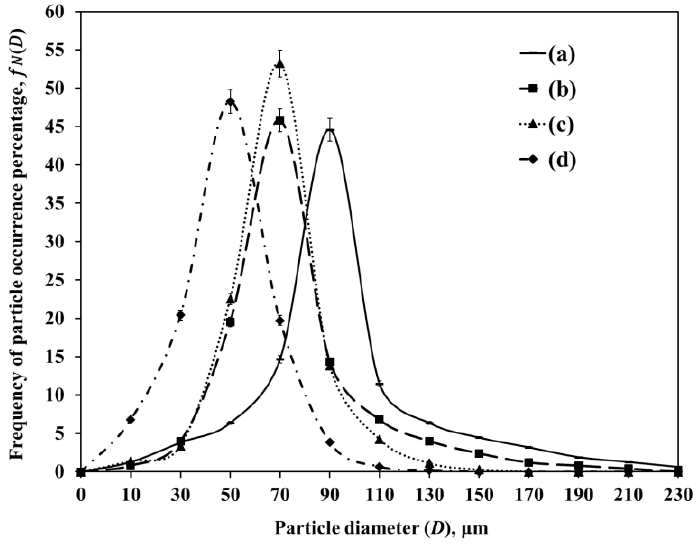
Figure 6. Particle diameter distributions of spray-dried 25SA products calcined at 550 °C, obtained at the following rotational speeds of the straight rectangular vanes disk: ( a ) 3000 rpm (P1–DAR), ( b ) 6000 rpm (P2–DAR), ( c ) 11,500 rpm (P3–DAR), y ( d ) 14,000 rpm (P4–DAR).